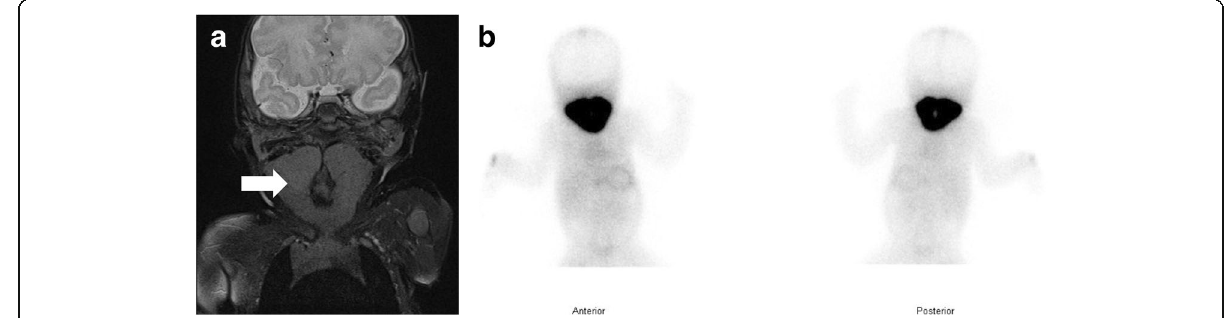
Fig. 1 Radiological investigations of the proposita at three weeks of age. a Magnetic Resonance Imaging of the neck showing significant enlargement and extension of the thyroid gland. The thyroid encircles the laryngeal and tracheal lucency, extending posteriorly almost to the midline. Inferiorly, it extends posterior to the clavicle with no retrosternal extension. b Tc-99 m pertechnetate thyroid scan demonstrating significantly increased radiotracer